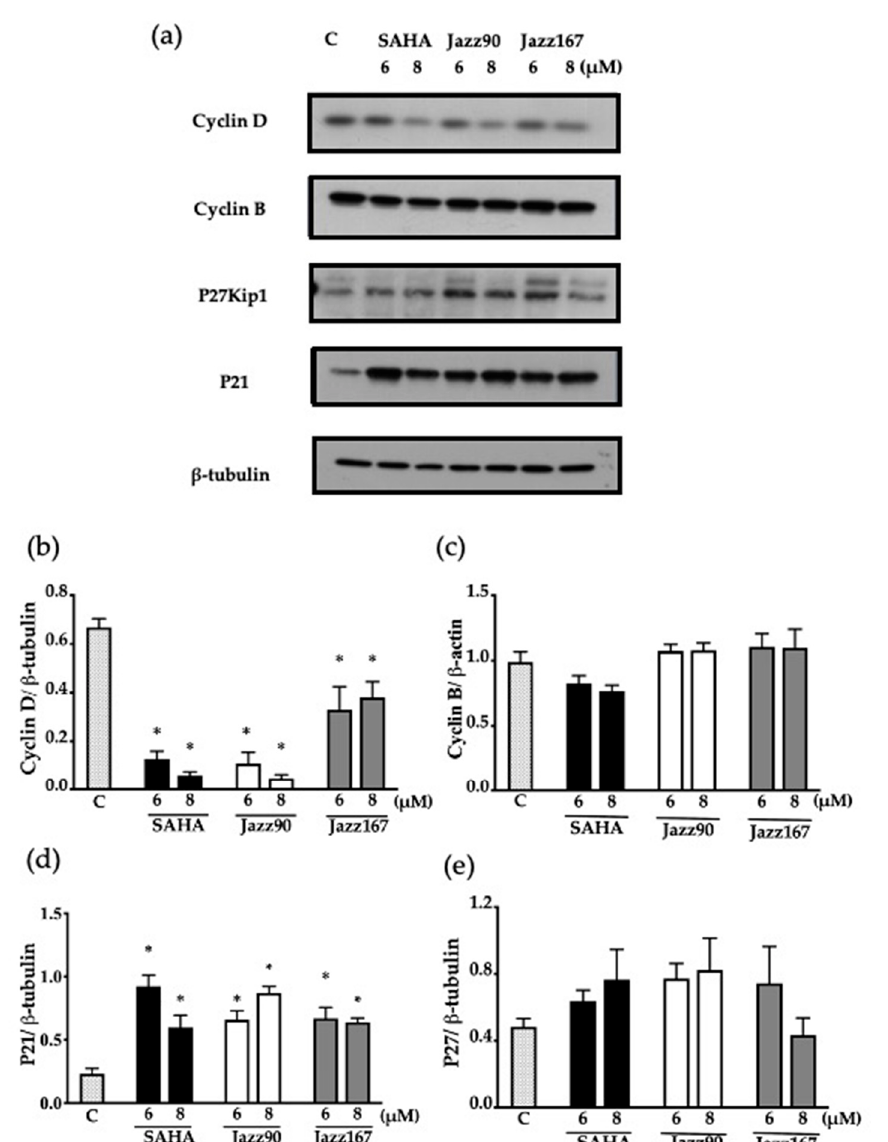
Figure 9. Cell cycle protein expression in Du145 cells. Cyclin D, cyclin B, p27kip1 and p21 levels were assessed in response to SAHA, Jazz90 and Jazz167 in PC3 cells at concentrations of 6 and 8 µM for 24 h. Vehicle control cells (C) were treated with 0.5% DMSO. Cell lysates were analyzed using Western blotting and β -tubulin was used as the loading control. ( a ) Representative blots for each of the proteins. Scanning densitometry graphs for ( b ) cyclin D, ( c ) cyclin B, ( d ) p21, and ( e ) p27kip1 are depicted. Bars represent the means ± S.E.M. from three independent experiments. Data were analyzed using a one-way ANOVA coupled with Bonferroni’s post hoc test; * indicates significant differences relative to the control, p < 0.05.